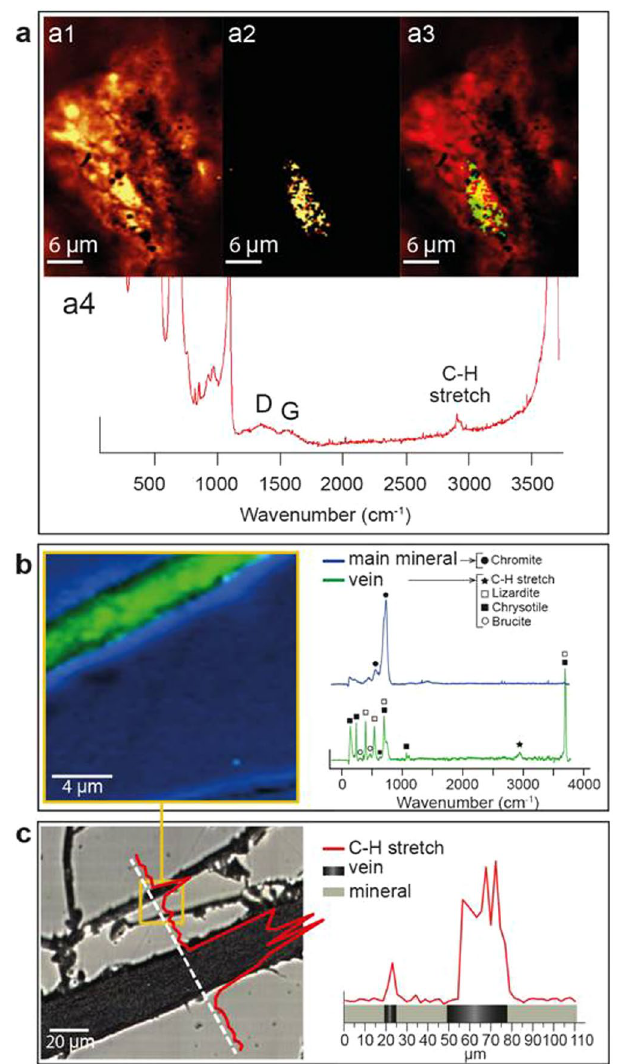
Figure 5. Examples of chemisorbed CH 4 detected by Raman analyses on chromitites. ( a ) Confocal Raman imaging of a fresh fracture surface of chip sample AET5; (a1) map of lizardite peak at 690 cm − 1 ; (a2) map of CH 3 symmetric vibration at 2938 cm − 1 ; (a3) overlay image of a1 and a2 as a red (lizardite), green (CH 3 ) composite. (a4) Lizardite spectra (yellow area in a3) with the D and G bands of amorphous carbon and the CH stretching region. ( b ) Raman spectral image in correspondence with a fracture in AET1 thin section showing the distribution of chemisorbed CH 4 (green) and main mineral (blue); ( c ) profile of calibrated chemisorbed CH 4 along fractures in